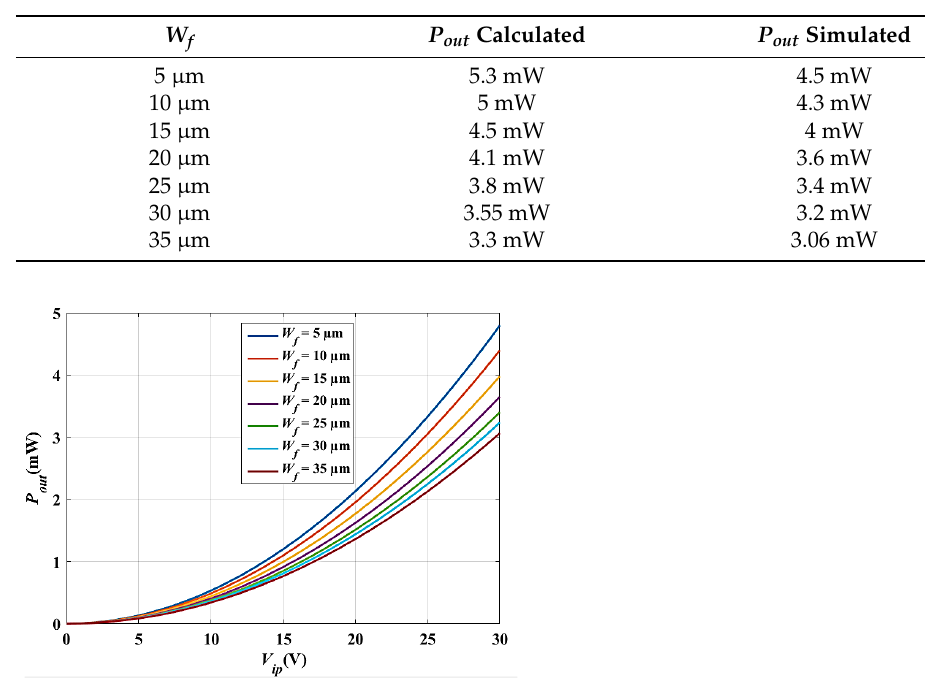
Table 2. P out at different W f.